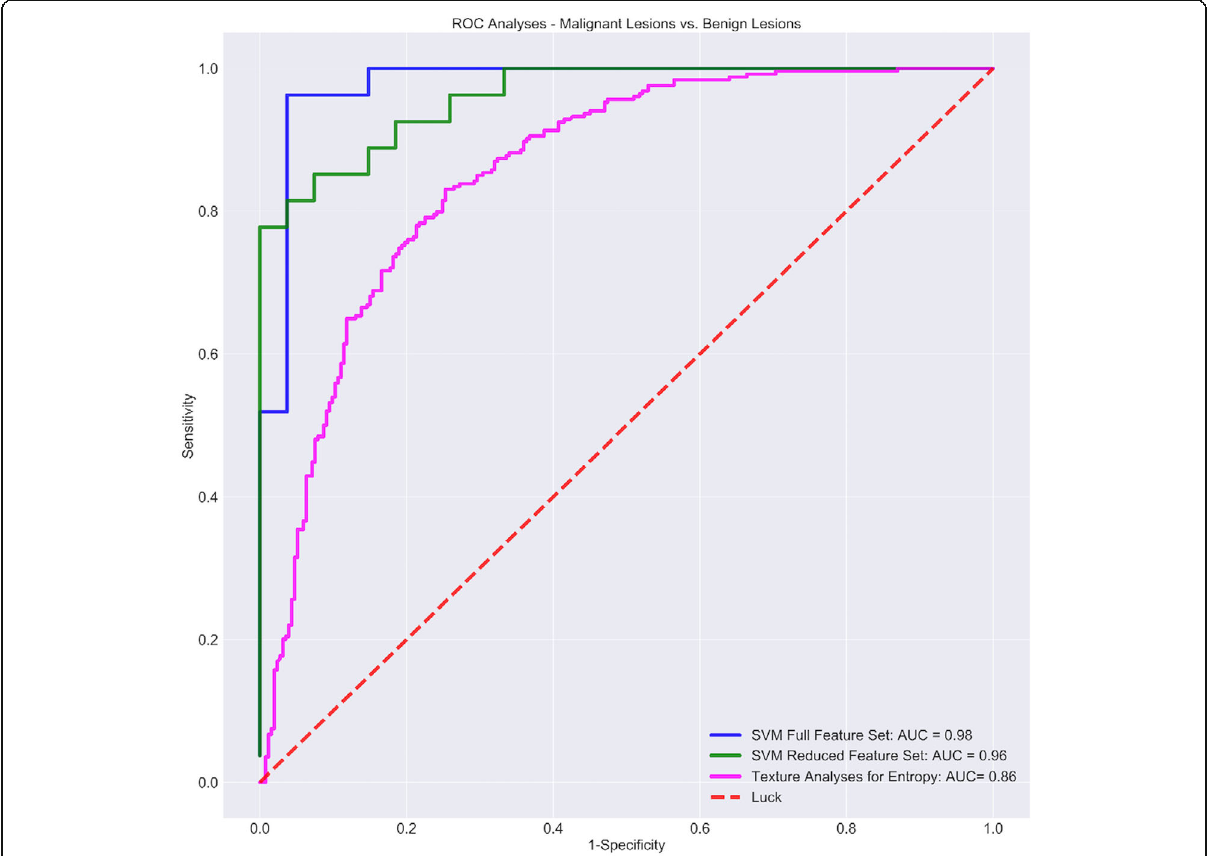
Fig. 3 Receiver operating characteristic (ROC) curve obtained from the texture analysis for entropy as well as ROC curves obtained with machine learning support vector machine (SVM) algorithm with full and reduced features when used to compare malignant versus benign solid breast lesions on automated breast